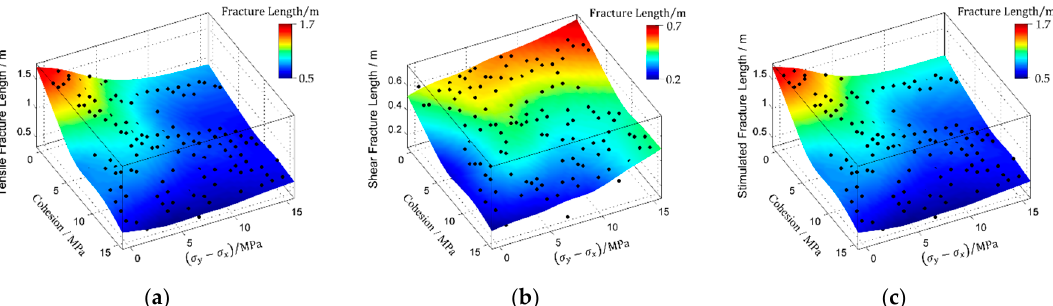
Figure 4. Variations of fracture lengths with stress difference and the cohesion of pre-existing fractures. ( a ) The variation of the tensile fracture length; ( b ) The variation of the shear fracture length; ( c ) The variation of the stimulated fracture length, i.e., the length of the fractures that are either tensile or shear fractures. In these figures, each black point represents the result of a simulation. The colored surfaces represent the smoothed results.